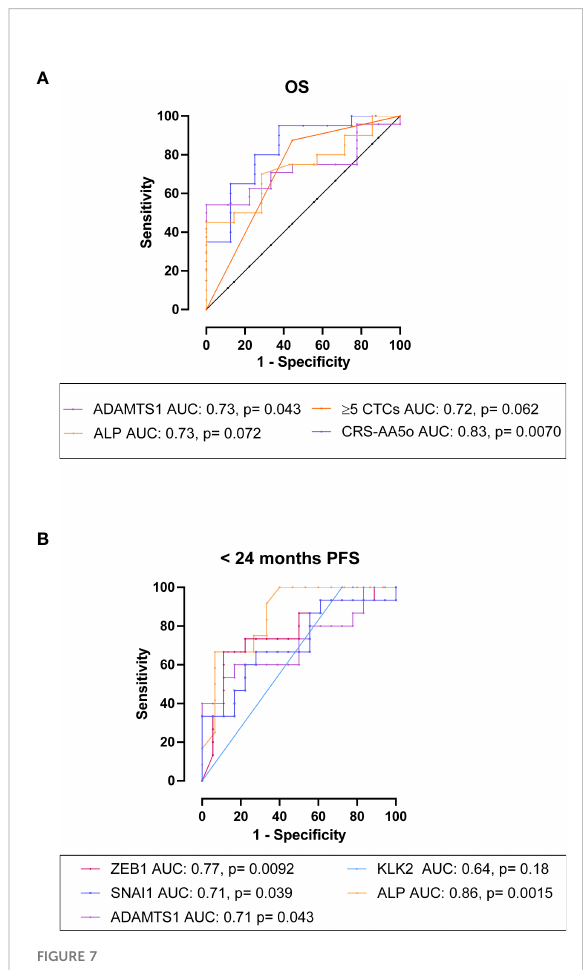
FIGURE 7 The association and predictive value of CTC gene expression with OS and PFS in mHSPC patients. (A) ROC analysis for OS: High expression of ADAMTS1 had an AUC of 0.73, p= 0.043 for the prediction of OS. Neither serum PSA or ALP levels signi fi cantly differentiated patients based on OS, although ALP showed a trend towards signi fi cance (AUC= 0.55, p= 0.66; AUC= 0.73, p= 0.072, respectively). Combining ADAMTS1 , ALP and ≥ 5 CTCs as CRS-AA5o= 0.06386* ADAMTS1 + 0.001465*ALP + 2.169* ≥ 5CTCs, increased the AUC to 0.83, p= 0.0070. (B) ROC analysis for <24 months PFS: High expression of ZEB1 , SNAI1 and ADAMTS1 was signi fi cantly predictive of <24 months PFS (AUC= 0.77, p= 0.0092; AUC= 0.71, p= 0.039; AUC= 0.71, p= 0.043, respectively). Additionally, ALP but not serum PSA levels showed signi fi cant AUCs (AUC= 0.86, p= 0.0015; AUC= 0.52, p= 0.86,